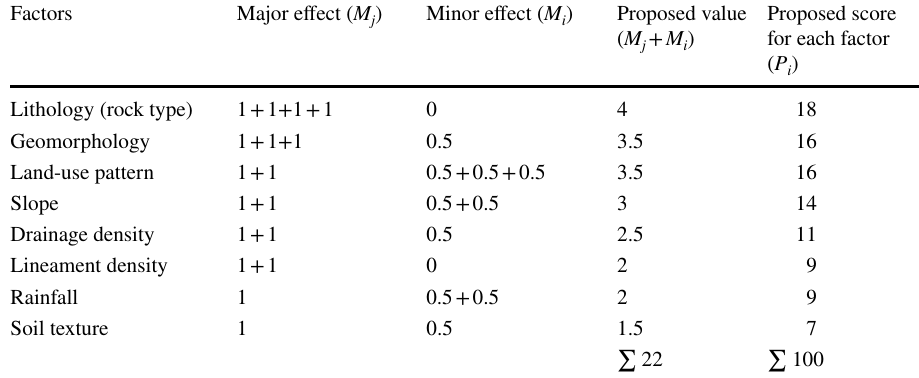
Refer Fig. 3 to understand the interrelation between all factors considered in this table for major and minor